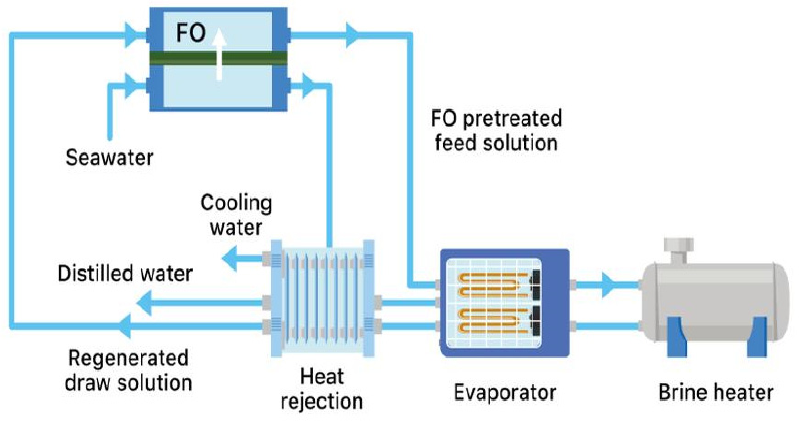
Figure 1. Schematic diagram illustrating the FO pretreatment of seawater to the MSF plant.